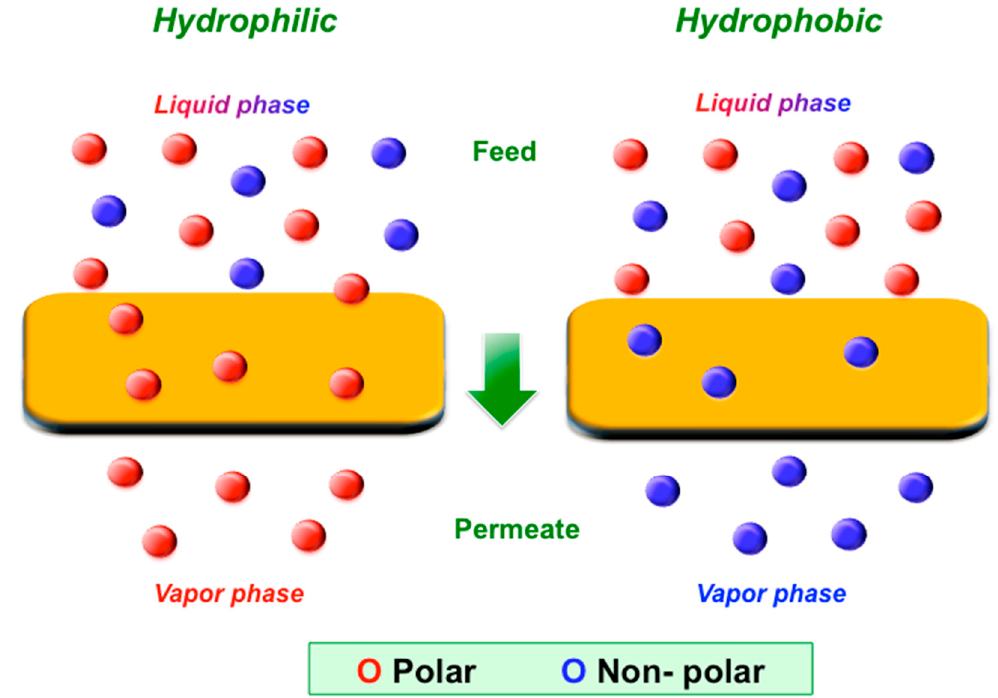
Figure 4. Graphical depiction of the separation mechanisms in pervaporation (PV) for hydrophilic and hydrophobic polymeric membranes towards mixtures of polar and non-polar